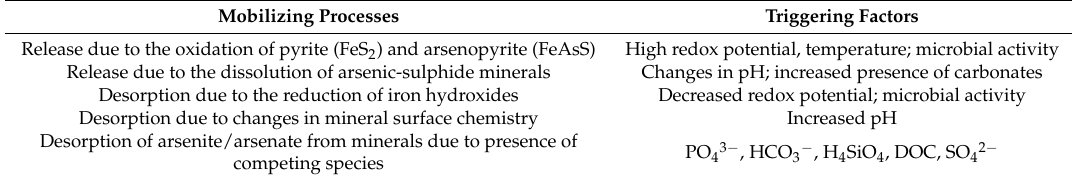
Table 3. Summary of arsenic mobilizing processes and triggering factors (from Pyne et al. [118]). Mobilizing